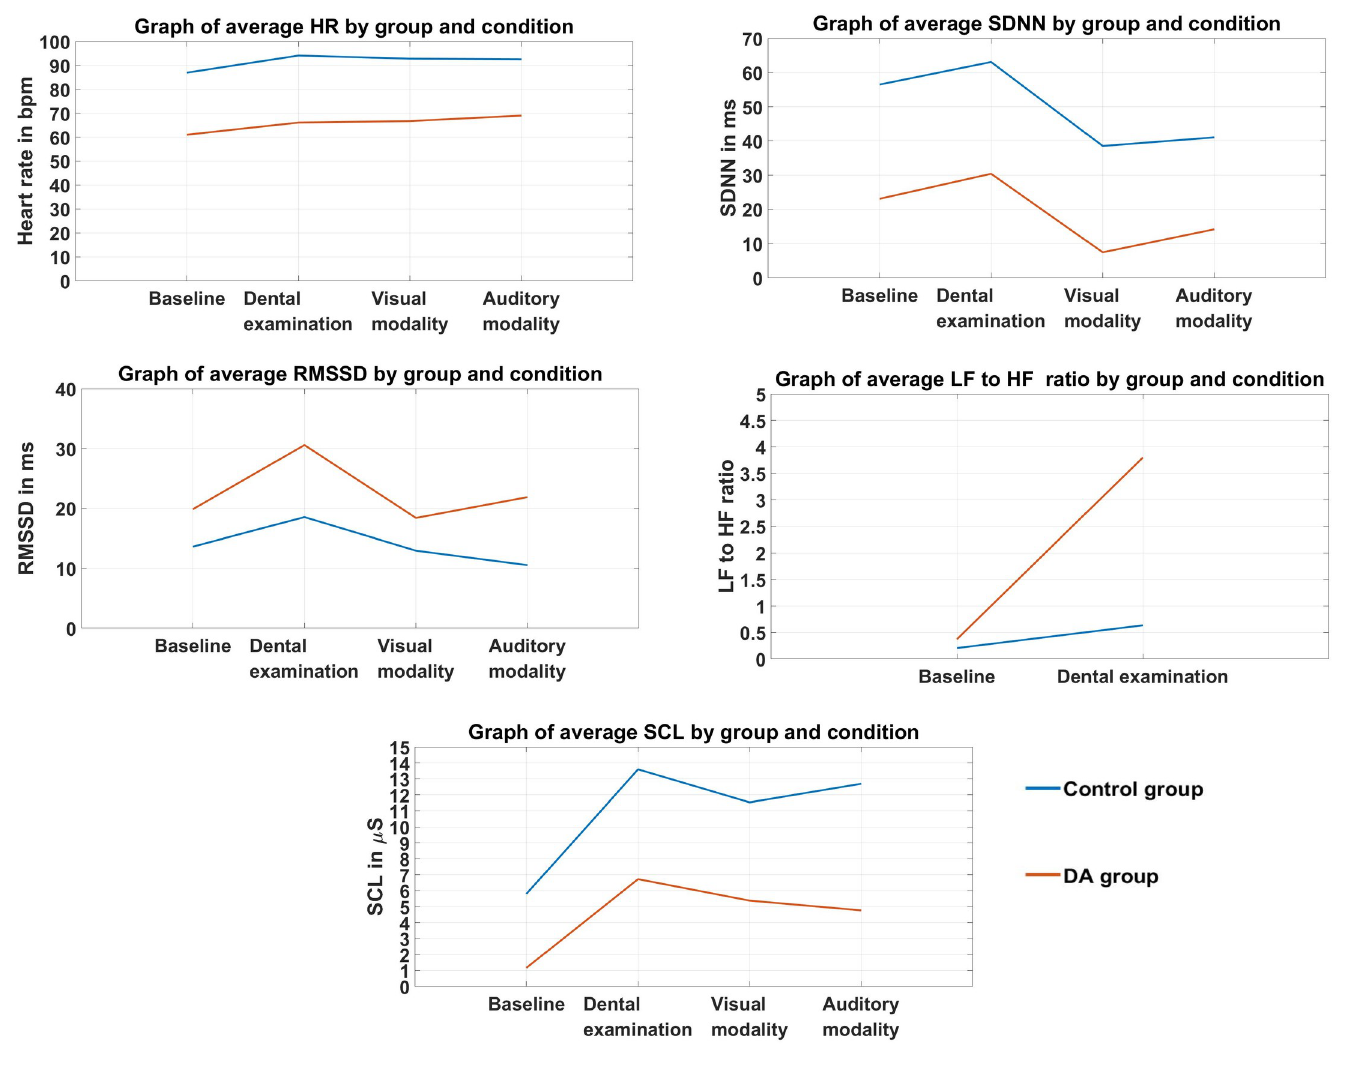
Fig 6. A summary of the results. All of the measured parameters are presented in Fig 6 for ease of visual comparison of group responses to different stimulus modalities and the real-life dental examination. DA group = dentally anxious group. Note that the plotted data is non-transformed.